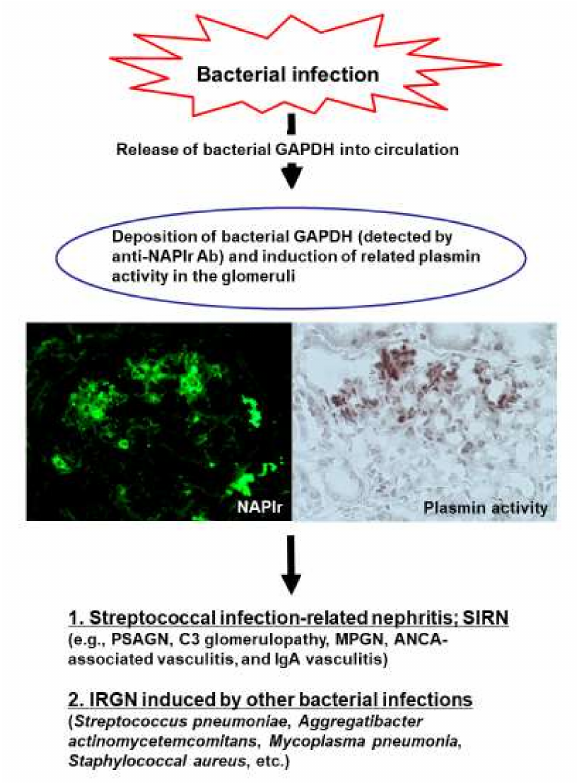
Figure 2. Possible scheme for the pathogenic mechanisms of bacterial infection-related glomerulonephritis (IRGN), focusing on the glomerular deposition of nephritis-associated plasmin receptor (NAPlr) and related plasmin activity. Ab: antibody; ANCA: antineutrophil cytoplasmic antibody; GAPDH: glyceraldehyde-3-phosphate dehydrogenase; MPGN: membranoproliferative glomerulonephritis; PSAGN: poststreptococcal acute